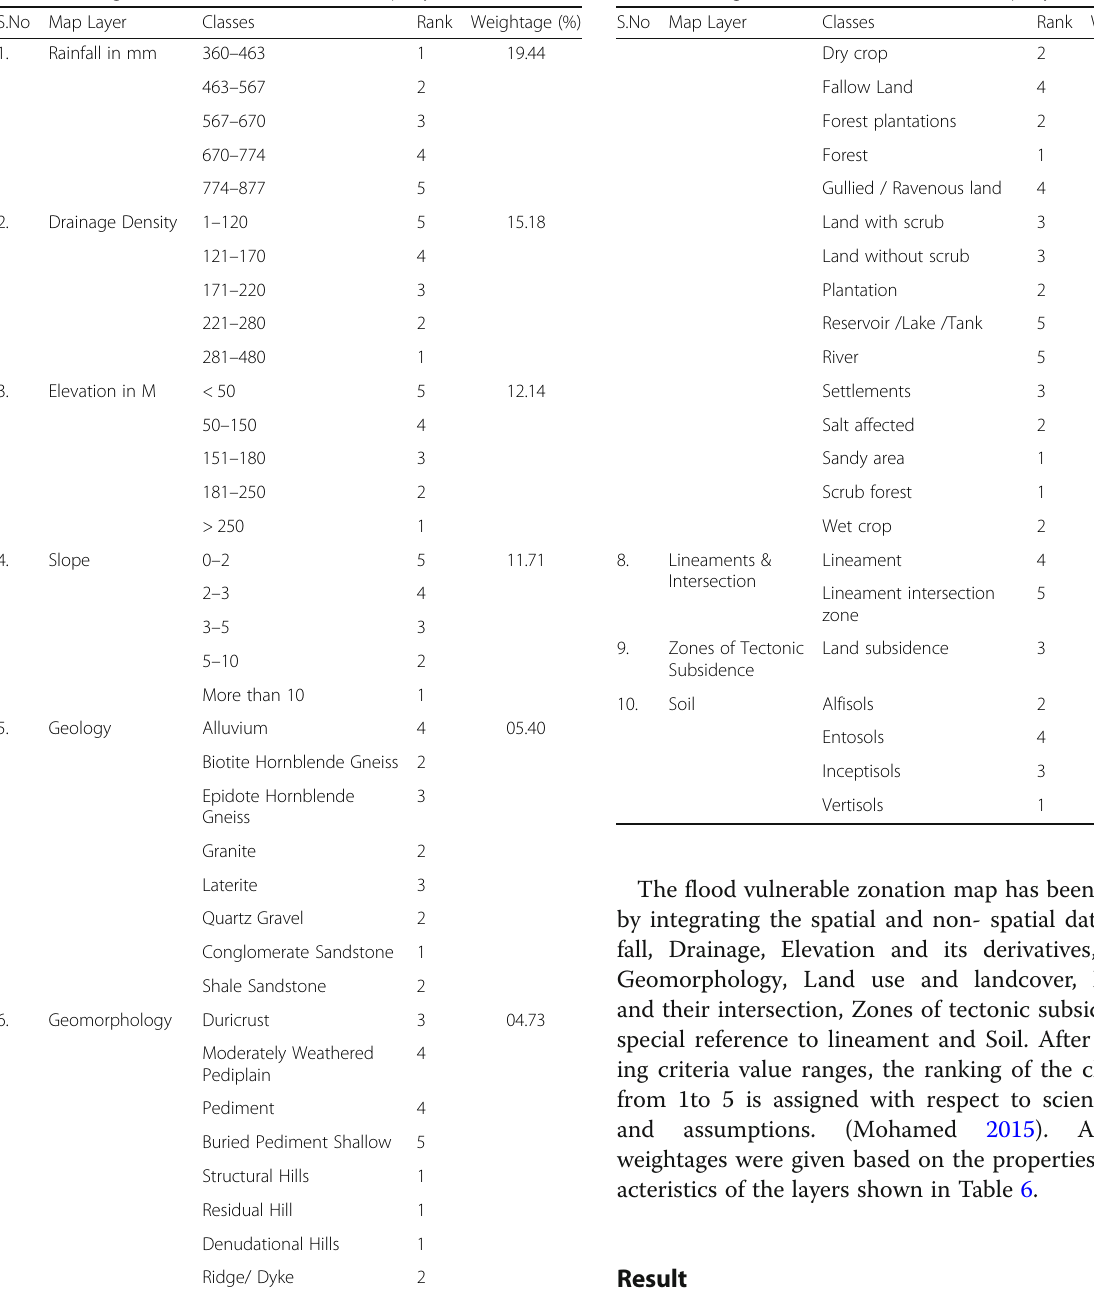
Table 6 Weights, classes and scores for map layers